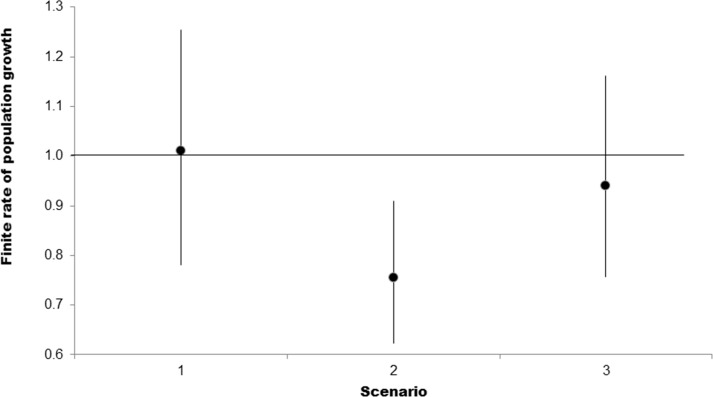
Finite rate of population growth (λ) mean (points) and 95% confidence intervals (bars) for different scenarios of C. porosus.Dashed line corresponds to the population equilibrium (λ = 1).